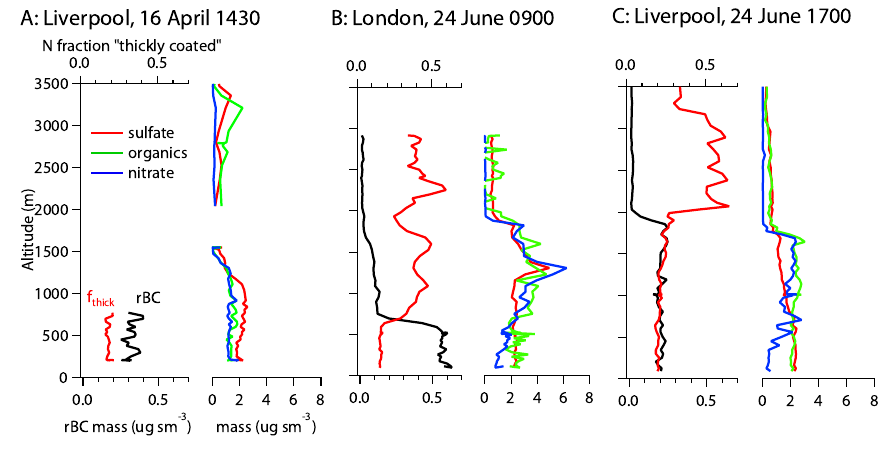
Fig. 9. Refractory black carbon (rBC) and sub-micron aerosol concentrations, composition and mixing state shown as a function of altitude in the vicinity of (a) Liverpool, England (approx. 14:30UTC on 16 April 2008), (b) London, England (approx. 09:00UTC on 24 June 2009) and (c) Liverpool, England (approx. 17:00UTC on 24 June 2009). All profiles are shown on the same